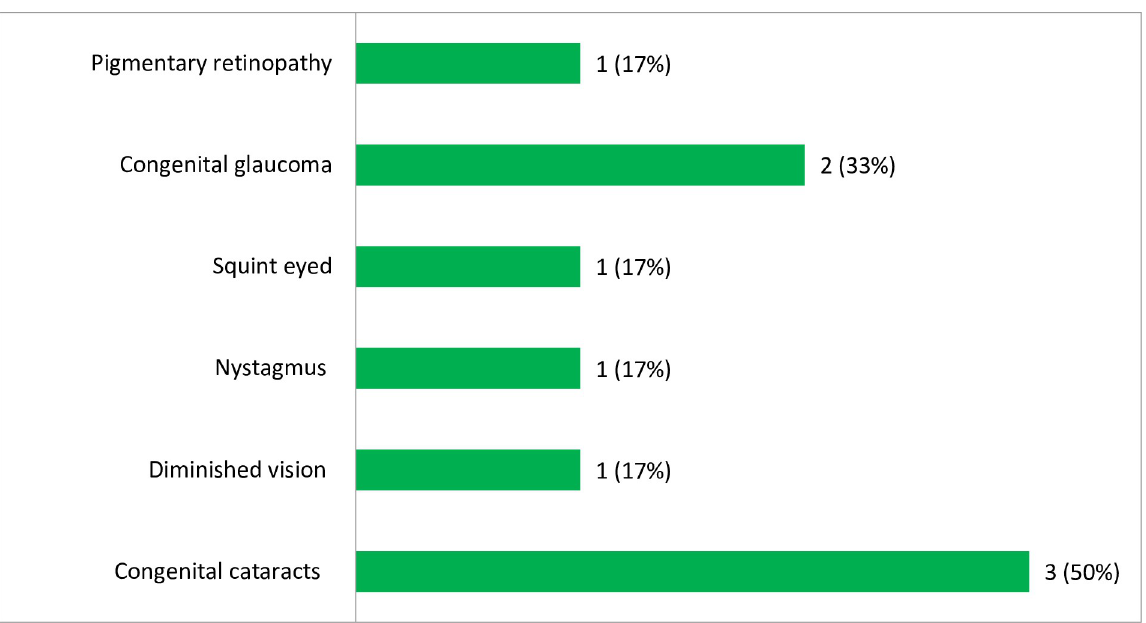
Fig 5. The frequency of different laboratory confirmed ocular manifestations among infants in Amhara Regional State Referral Hospitals, Northwest Ethiopia, December 2015-August